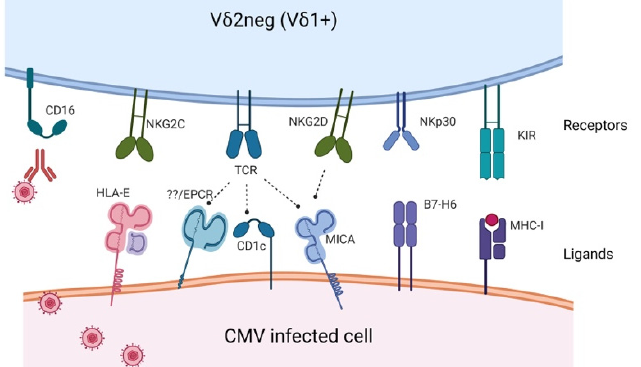
Figure 1. Receptors and ligands that are potentially involved in human cytomegalovirus (CMV) immune response by γδ T cells (created with BioRender.com, April 2021).